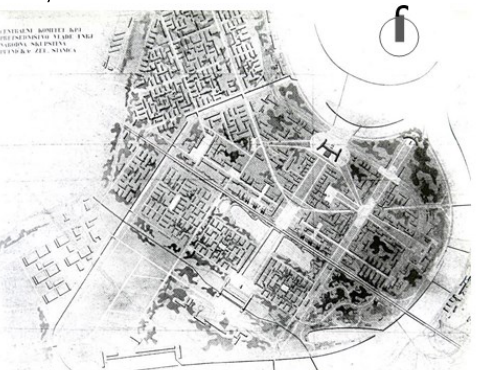
Figure 5. A conceptual plan of Nikola Dobrović for New Belgrade on the left bank of the Sava river 1948